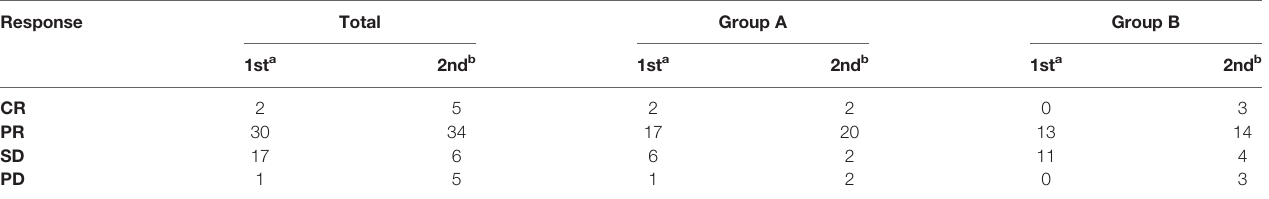
TABLE 3 | Response to treatment.